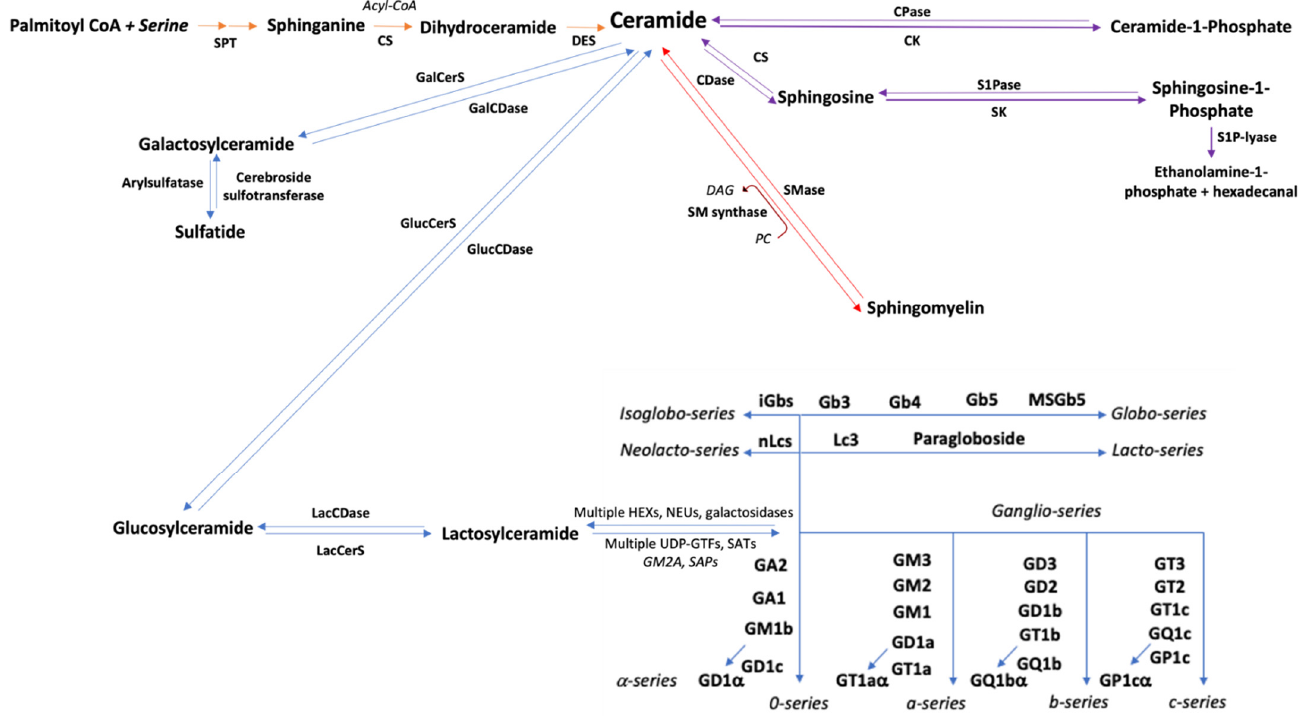
Figure 1. Overview of sphingolipid metabolism. SPT: serine palmitoyltransferase; CS: ceramide syn- thase; DES: dihydroceramide desaturase; CDase: ceramidase; SK: sphingosine kinase; S1Pase: sphingosine-1-phosphate-phosphatase; S1P-lyase: sphingosine-1-phosphate lyase; S1PR1: sphingo- sine-1-phosphate receptor 1; CK: ceramide kinase; CPase: ceramide-1-phosphate-phosphatase; SMS: sphingomyelin synthase; SMase: sphingomyelinase; PC: phosphocholine; DAG: diacylglycerol; GluCerS: glucosylceramide synthase; LacCerS: lactosylceramide synthase; HEXs: hexosaminidases; NEUs: neuraminidases; GTFs: glycosyltransferases; SATs: sialyltransferases; GM2A: ganglioside ac- tivator protein; SAPs: sphingolipid activator proteins (saposins); GlucCDase: glucosylceramidase; GalCerS: galactosylceramide synthase; GalCDase: galactosylceramidase. Considerations: Orange arrows depict de novo pathway. Purple arrows depict salvage pathway. Red arrows depict SM cy- cle. Blue arrows depict GSL metabolism. CDase and SMase have acid, alkaline, and neutral isotypes, depending on the subcellular compartment. Multiple intracellular transporters (CERT, FAPP2, CPTP, SPNS2, Mfsd2d, GLTP) move newly synthesized sphingolipids across subcellular compart- ments to ensure proper distribution.